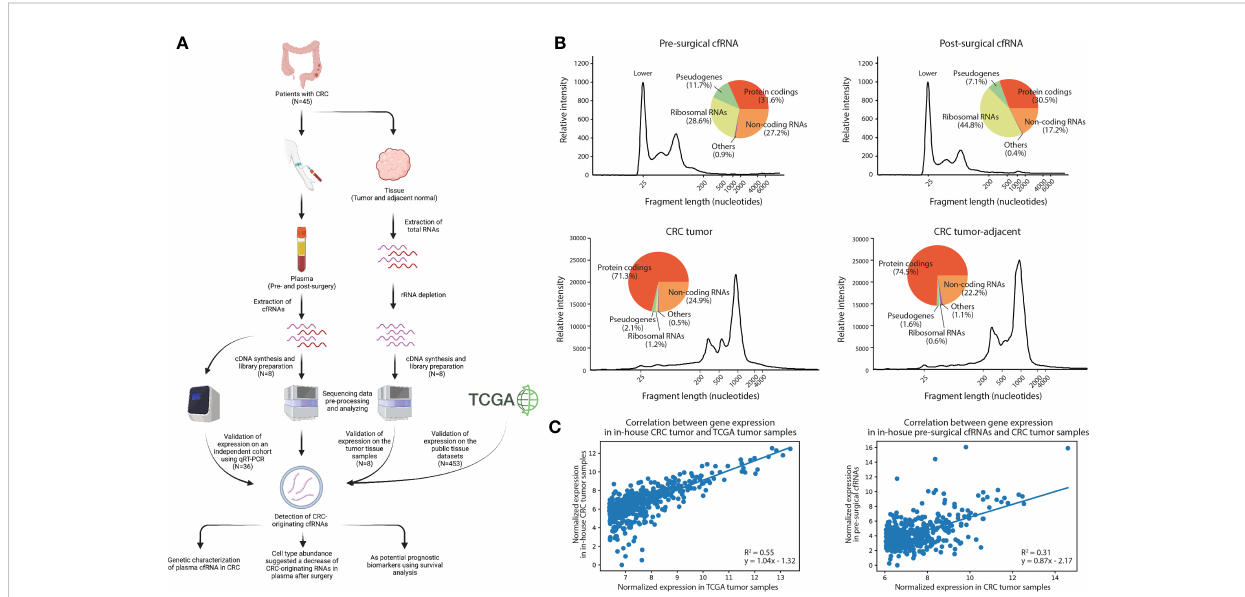
FIGURE 1 Analytical characterization of cell-free RNA and tissue transcriptome. (A) Experimental design of the study, Created with BioRender.com. (B) Relative intensity across different fragment lengths of plasma and tissue transcriptomes in a patient with CRC. Pie charts showed the percentage of gene expression in each biotype. (C) Correlation between gene expression of the top expressed genes in in-house tumor samples and TCGA datasets, and plasma and tissue datasets. The top 500 expressed genes in TCGA and in-house tissue were selected,